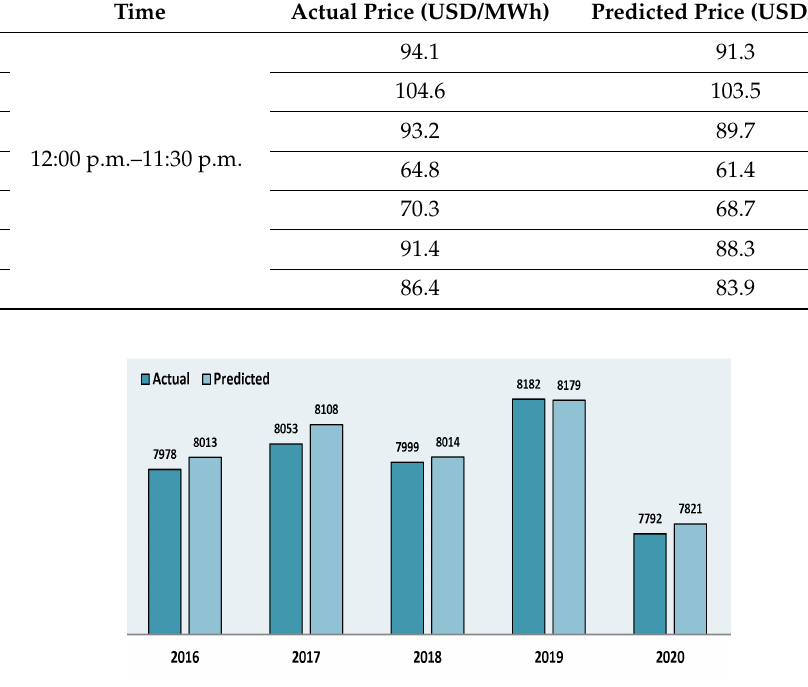
Figure 7. Actual and Predicted Demands (MW) (2016–2020).